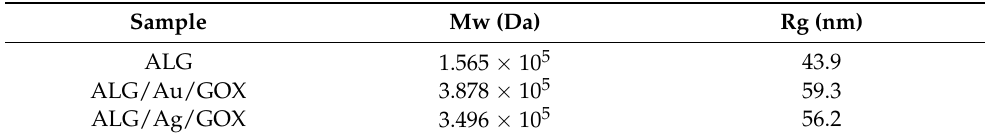
Table 1. The average molecular weight (Mw) and radius of gyration (Rg) of ALG, ALG/Au/GOX and ALG/Ag/GOX.